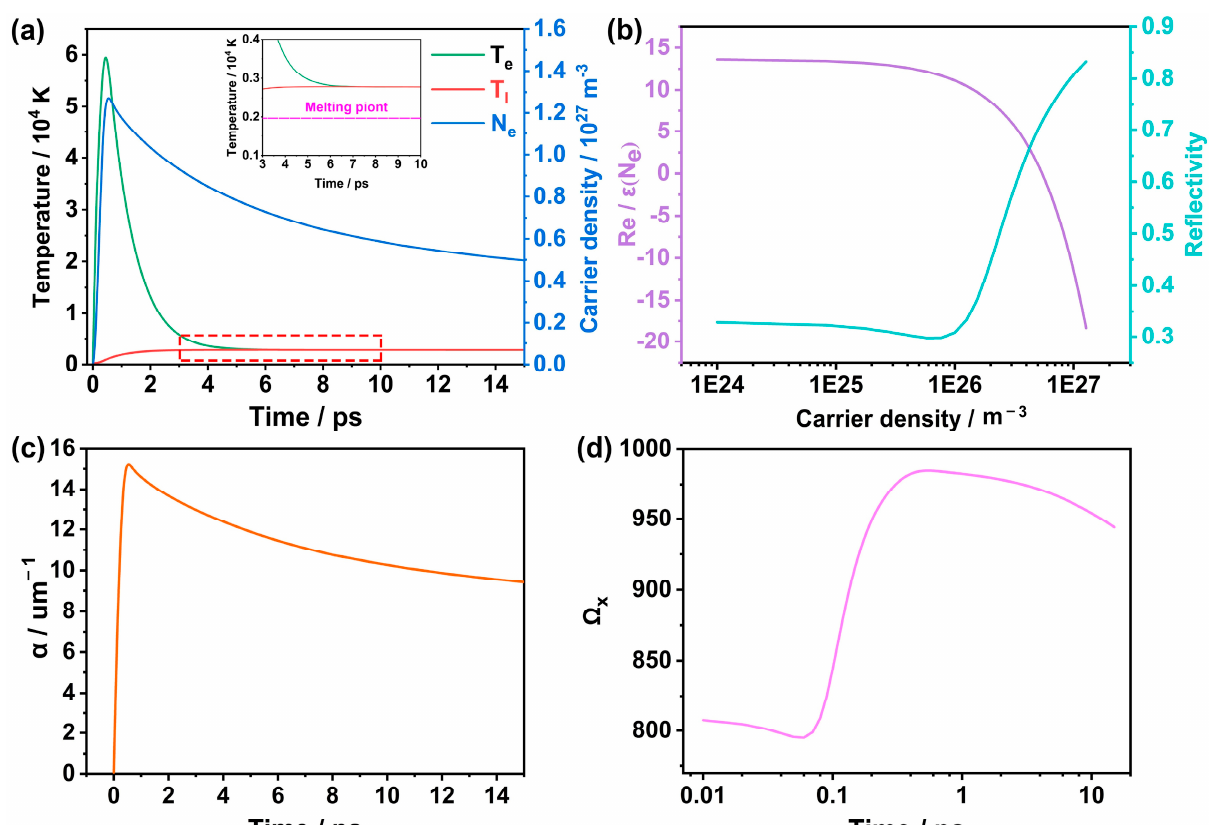
Figure 3. ( a ) Calculated T e , T l , and N e as a function of time, the inset indicates details of the evolution of T e and T l from 3 to 10 ps; ( b ) calculated the real part of the dielectric constant and reflectivity as a function of carrier density; ( c ) time dependence of the evolution of absorption coefficient; ( d ) wave- length period of SPP as a function of time.